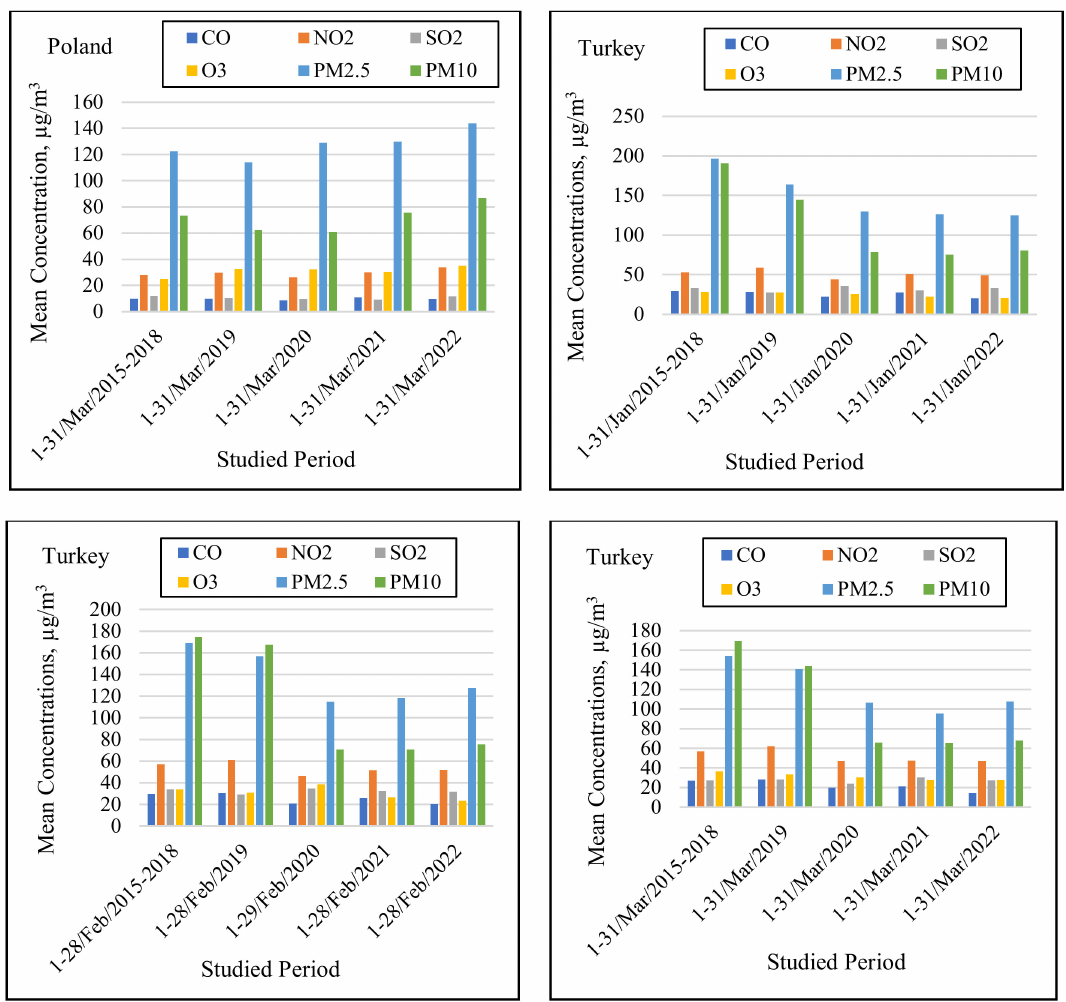
Figure 4. Average concentrations of air pollutant in countries of the European geoeconomic region. Note: In Germany, the concentration of CO varied in the range of 0.10–0.26 µ g/m 3 for the examined periods. Since CO concentration was low compared with the concentrations of other pollutants, it is not included in the